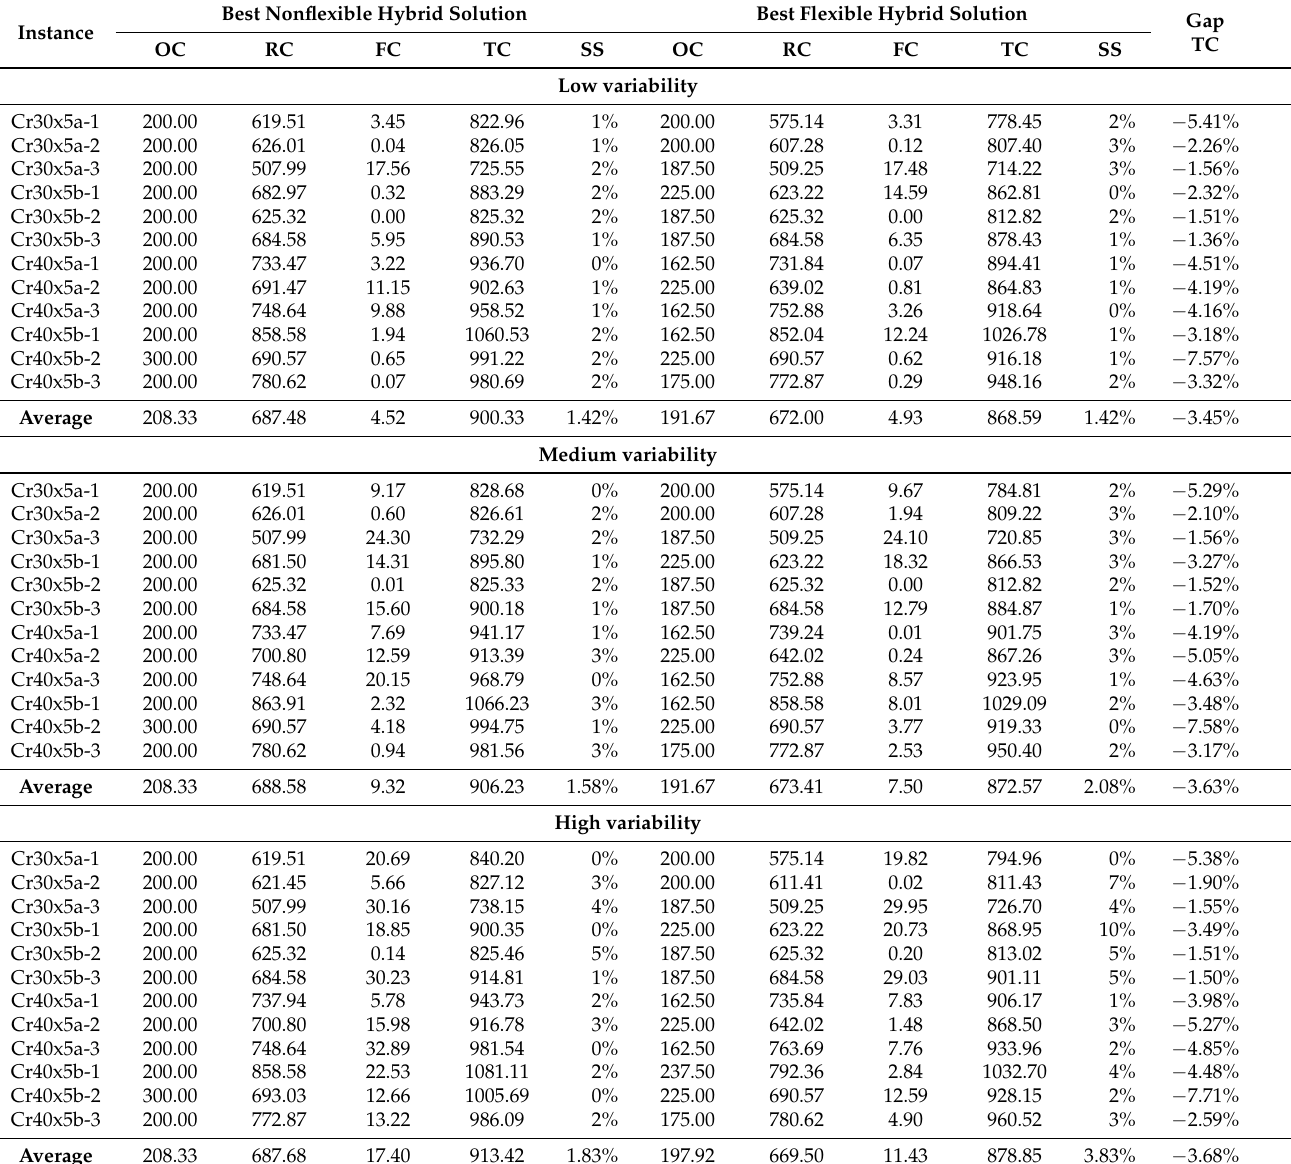
Table 4. Comparative results between our hybrid solutions when considering facility sizing decisions. Best Nonflexible Hybrid Instance